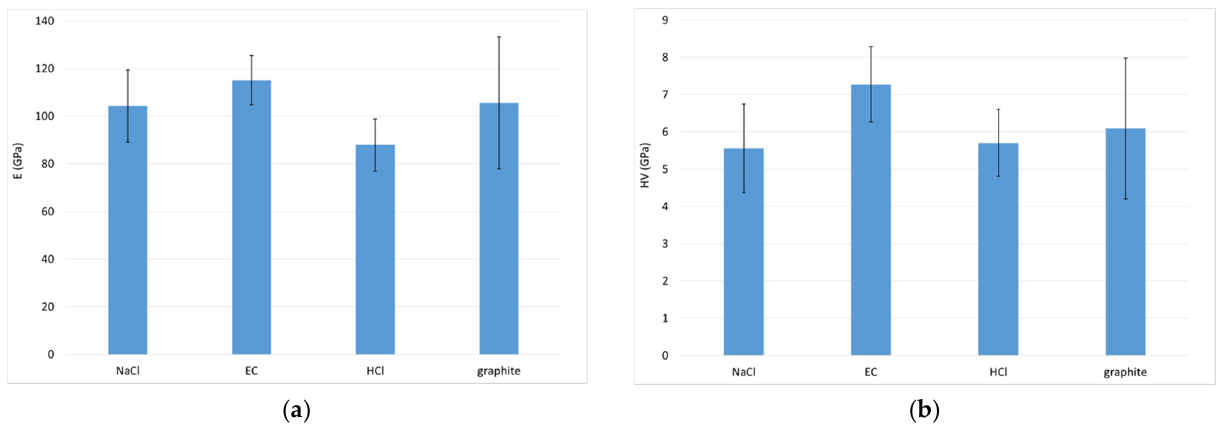
Figure 7. Results of the indentation tests on free-standing YSZ coatings, ( a ) Young’s modulus, ( b ) hardness. See Table 1 for the details of different substrate removal